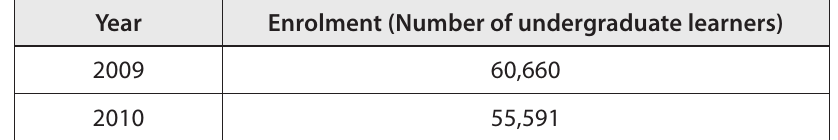
Table 2 Total OUM undergraduate enrolment in 2009 and 2010 Source: OUM annual report 2010